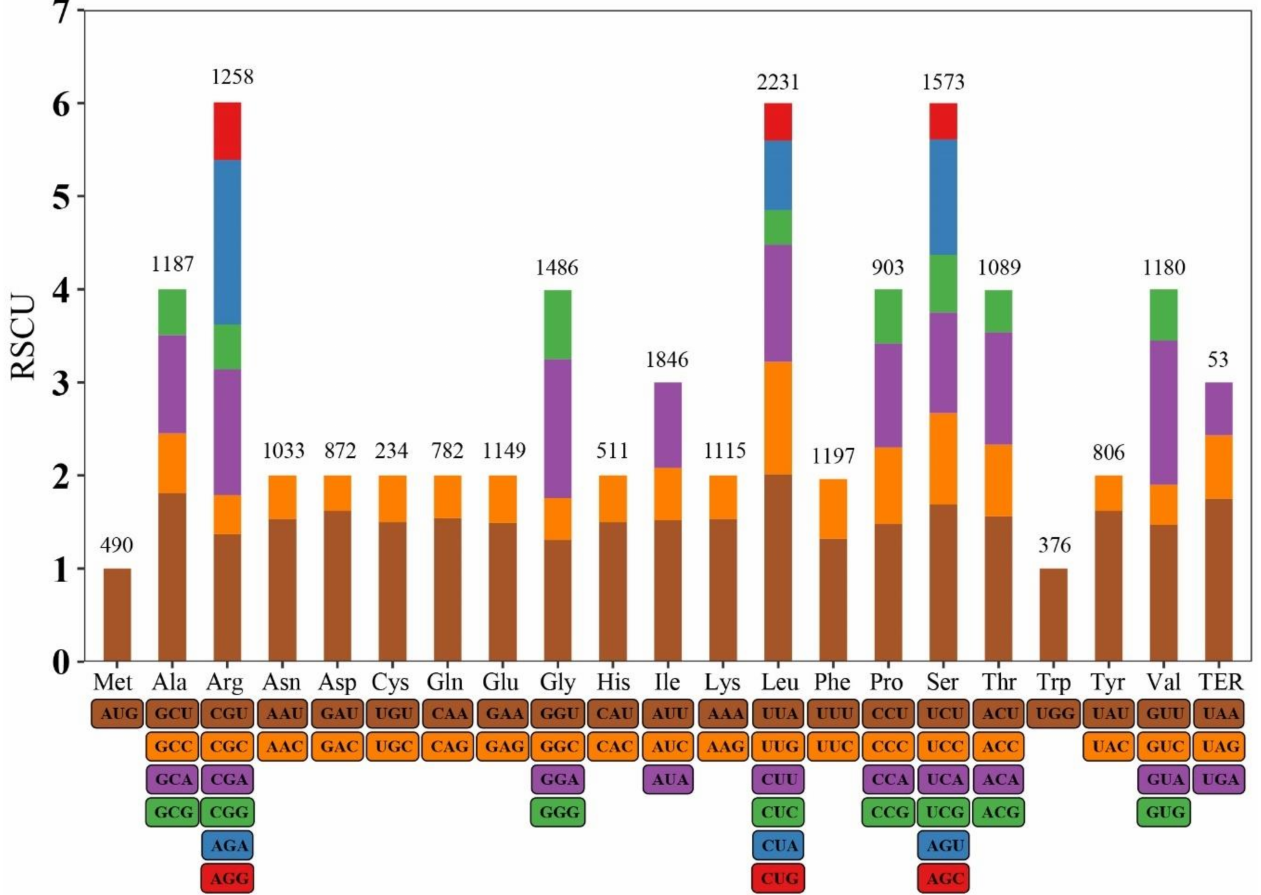
Figure 2. Codon content of 20 amino acids and stop codons in 53 coding genes of the Rosa lucieae chloroplast genome. The color of the histogram corresponds to the color of